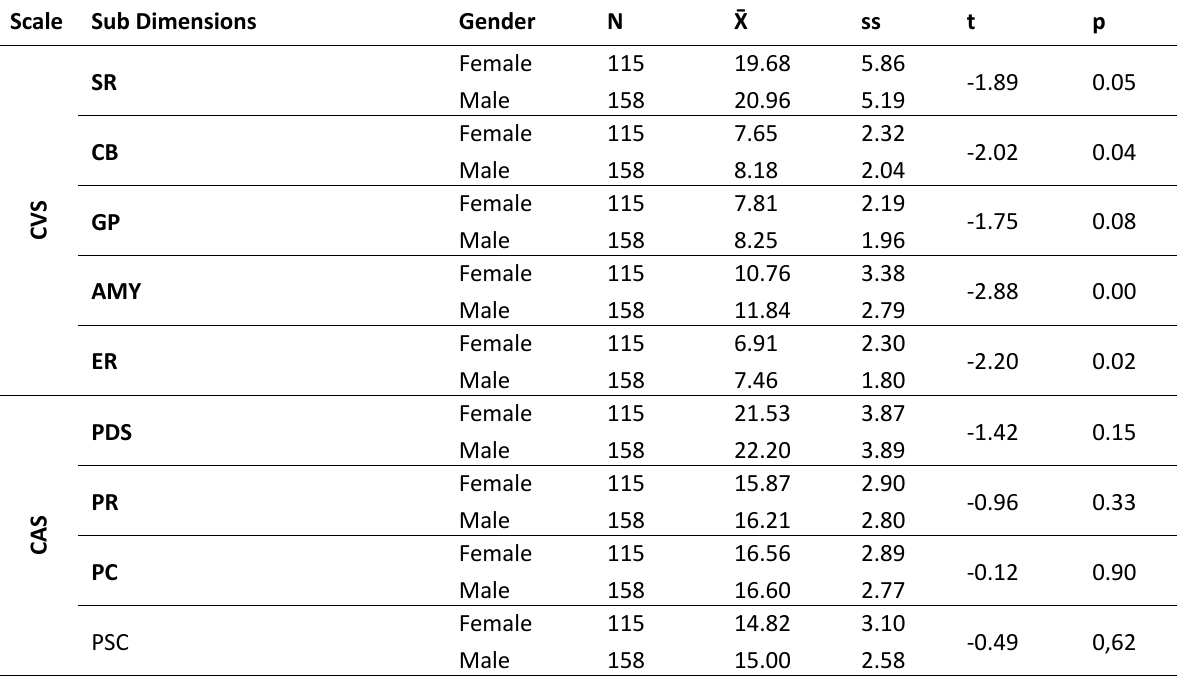
Table 3. CVS and CAS sub-dimension t-test results of the participants in terms of the type of Gender Scale Sub Dimensions